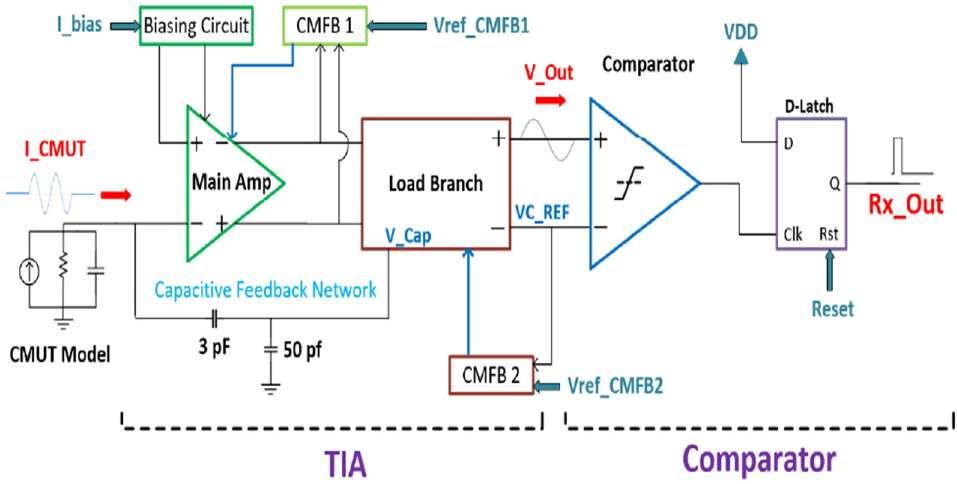
Figure 9. Analog receiver chain.